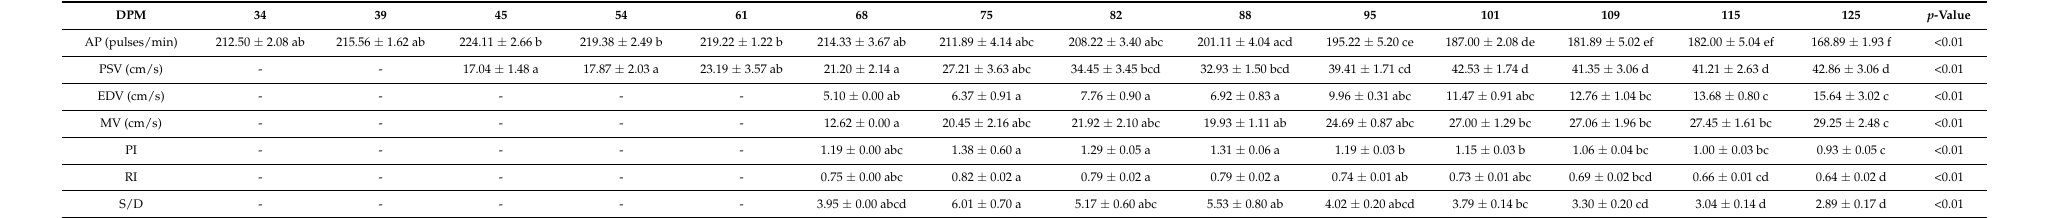
Table 2. Doppler indices of umbilical artery blood flow, measured on different days post-mating (dpm) throughout gestation in total goats under study ( n : 9). Mean ± Standard Deviation (SD). DPM: days post-mating, AP: Arterial Pulse, PSV: Peak Systolic Velocity, EDV: End Diastolic Velocity, MV: Mean Velocity, PI: Pulsatility Index, RI: Resistance Index, S/D: Systolic/Diastolic ratio. a–f: Different letters in the same row indicate significant